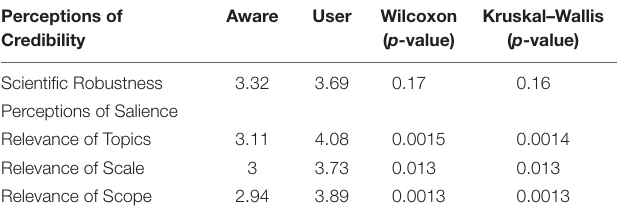
TABLE 1 | The mean credibility and salience scores provided by survey